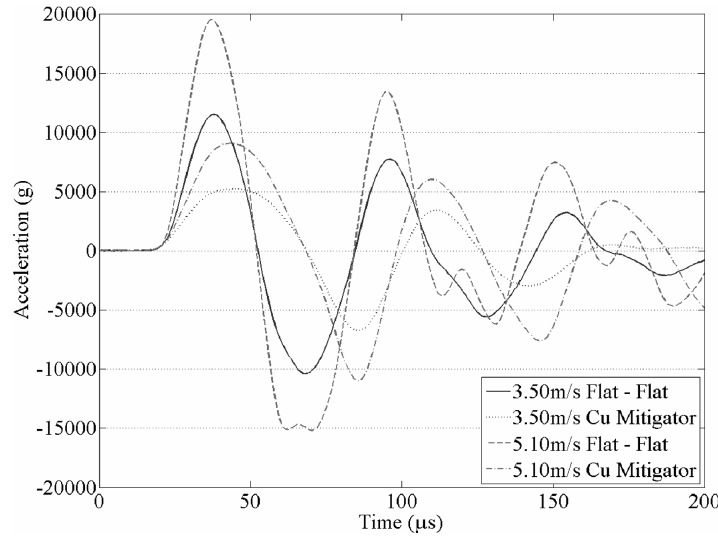
Fig. 7. VAMP acceleration traces displaying the effects of applying annealed copper mitigators with the Ti – 60 – 120 configuration.